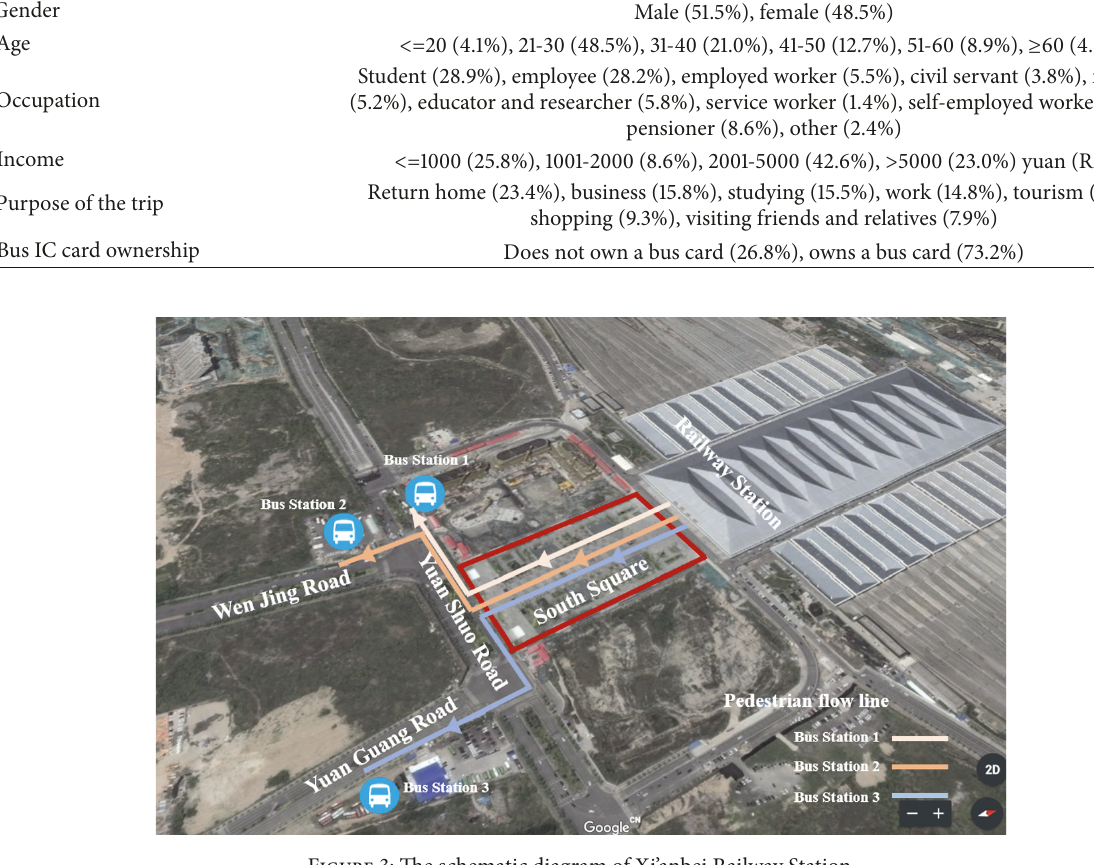
Figure 3: The schematic diagram of Xi’anbei Railway